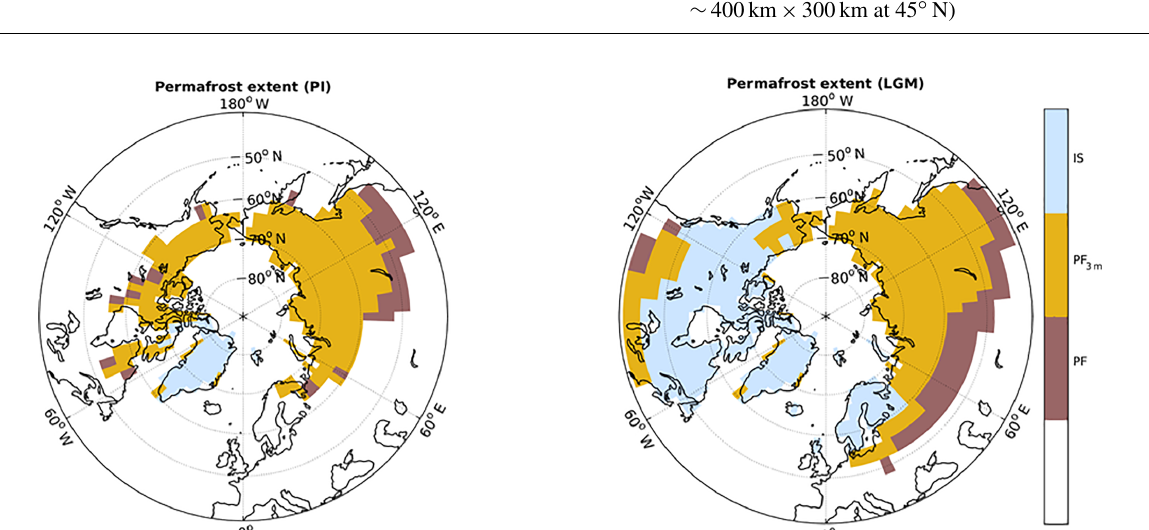
Figure 2. Ice sheet coverage and permafrost extent at PI and LGM simulated with JSBACH. Mustard-coloured areas illustrate grid cells of simulated near-surface permafrost with active layers above 3m (PF 3 m ), brown-mauve-coloured areas describe permafrost with active layers deeper than 3m (PF). Light-bluish-coloured areas show prescribed ice sheet coverage (IS). Data shown represent 100-year time